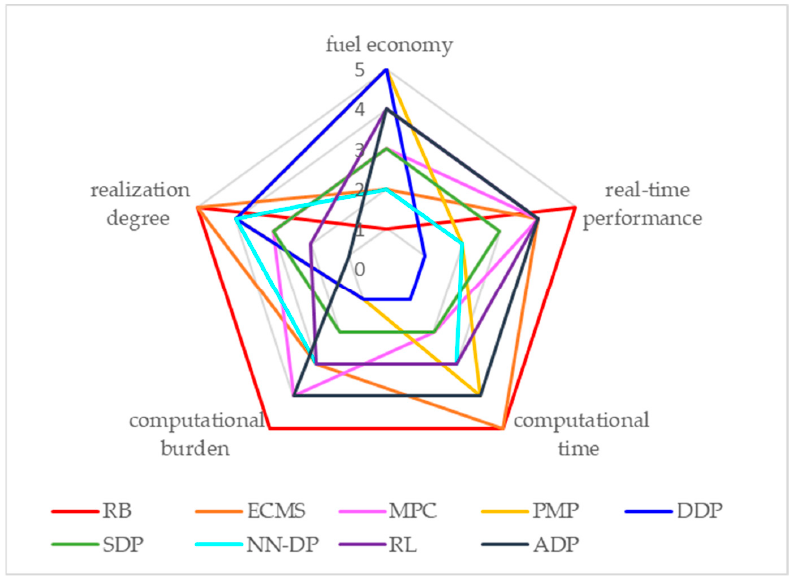
Figure 13. Depiction of the performance of each control strategy.